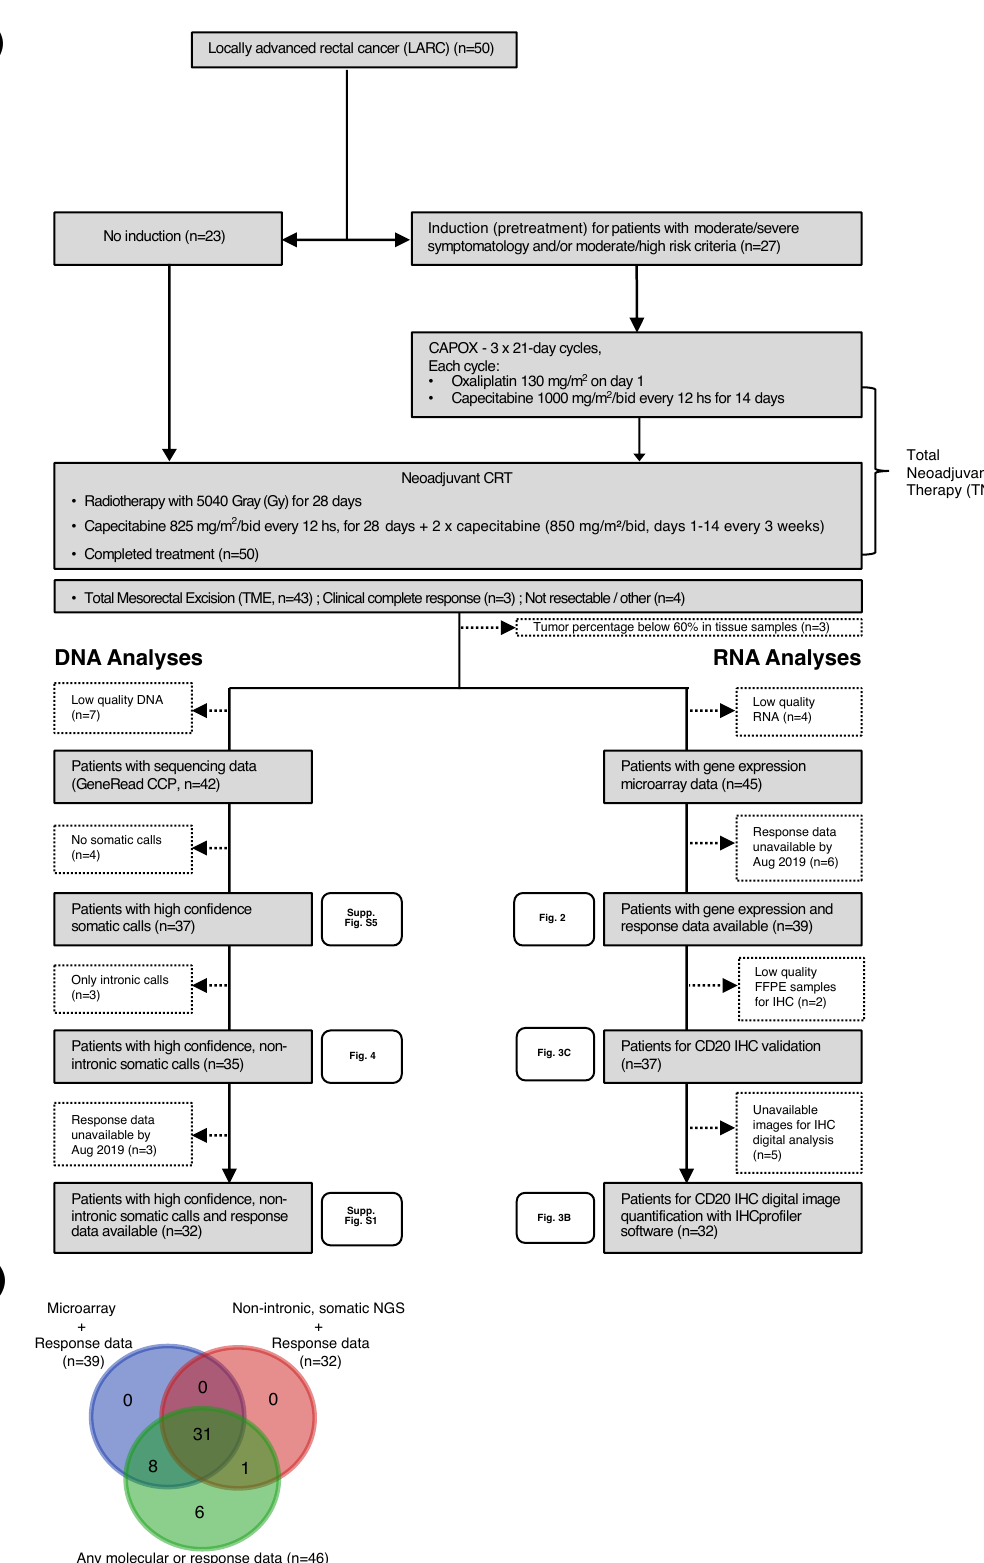
Figure 1. Description of the study design and participants. ( a ) Flow chart showing the cohort’s composition, outcomes and results. ( b ) Venn diagram displaying sample sizes and availability for the different molecular analyses